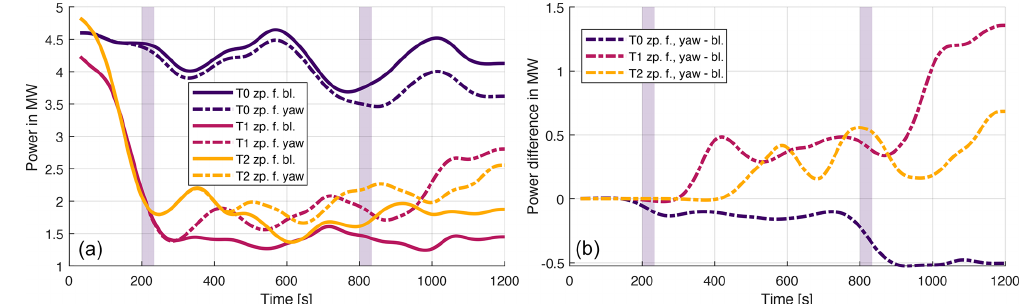
Figure 8. Comparison between the zero-phase-filtered (zp.f.) SOWFA data in the baseline case (bl.) and in the yaw case. (a) In absolute values; (b) with the difference between the yaw case and the baseline case. The transparent bars indicate the time window in which turbine T0 increases its yaw angle, first from 0 to 10 ◦ and then to 20 ◦